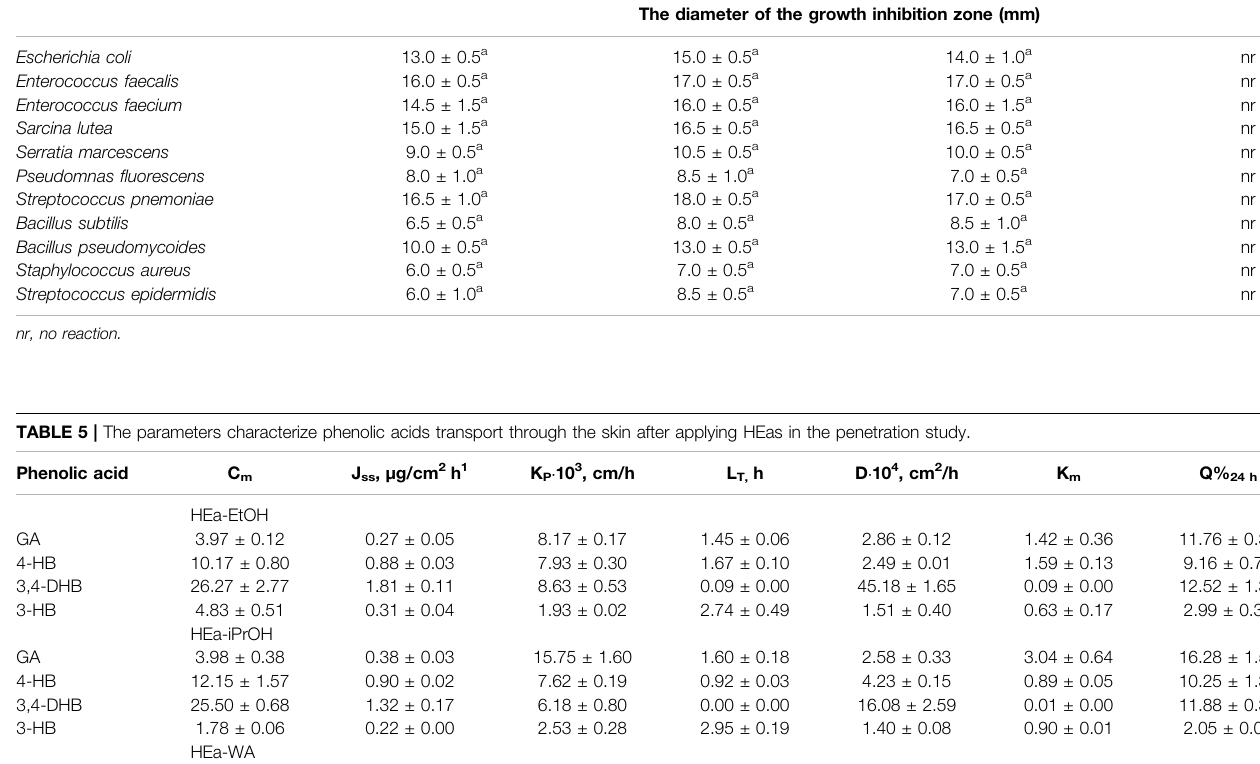
Escherichia coli